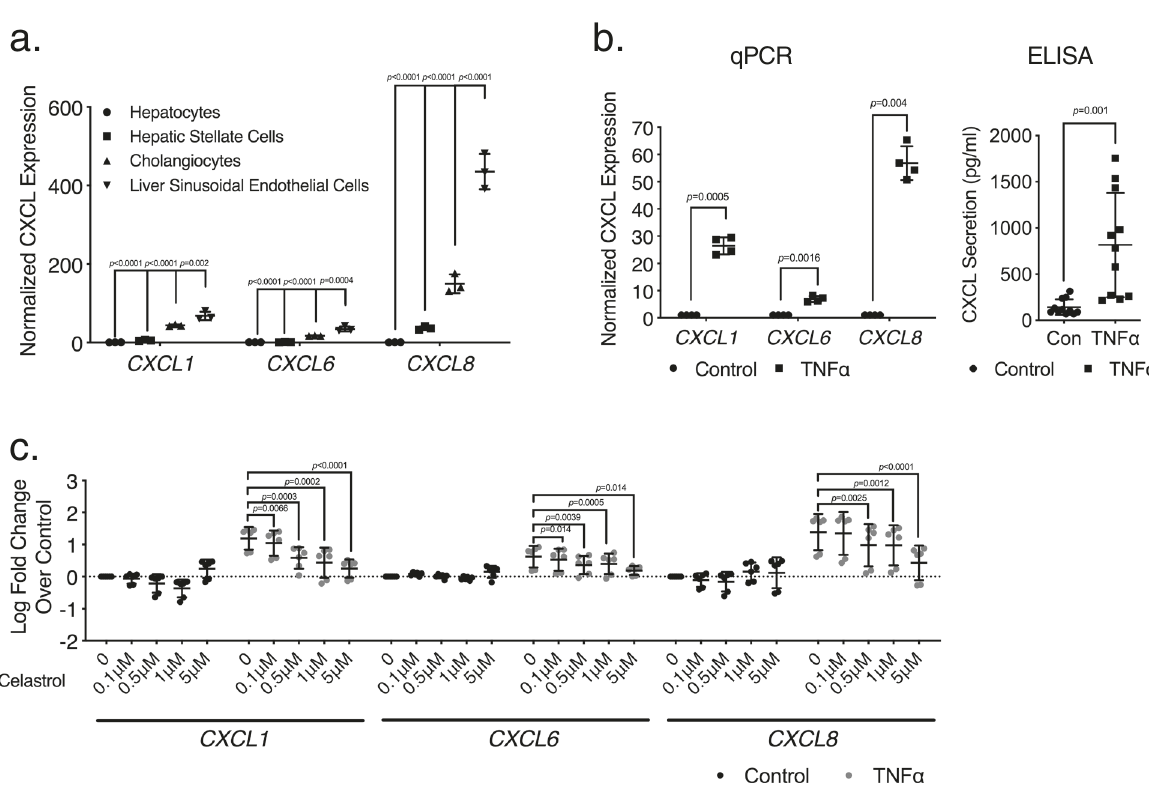
Fig. 2 LSECs are a major source of CXCL chemokines in the liver under the control of TNF α /NF- κ B signaling. a RNA-seq of normal liver cell types. Expression levels of CXCL genes (expressed in RPKM) were normalized (see supplemental methods for normalization details) and ratios are plotted. Data represented as mean ± SD. One-way ANOVA analysis was performed, with post hoc Dunnett ’ s multiple comparison correction ( n = 3 biologically independent samples for each cell type). b TNF α signi fi cantly increased expression of CXCL chemokines revealed by qPCR ( n = 4, biologically independent samples from two independent experiments, experiments repeated more than fi ve times with similar results) and by ELISA ( n = 11, biologically independent samples from three independent experiments). CXCL chemokines expression is shown as fold change over control condition for qPCR and as pg/ml by ELISA. Data represented as mean ± SD. A two-sided, paired t -test analysis was performed. c LSECs were pretreated with varying amounts of Celastrol (0 to 5 μ M) and exposed to medium with or without TNF α . qPCRs were performed for quantifying the expression of CXCL1 , 6 , and 8 , and shown in log 10 fold over basal expression. Data represented as mean ± SD. One-way matched-pairs ANOVA analysis was performed with post hoc Dunnett ’ s multiple comparison correction ( n = 6, biologically independent samples from three independent experiments). There was a signi fi cant linear trend of decreasing CXCL1 , 6 , 8 expressions with increasing Celastrol concentrations with TNF α ( p < 0.0001 for all